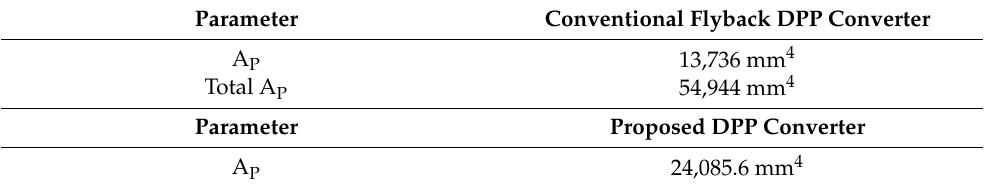
Table 2. Transformer A P.